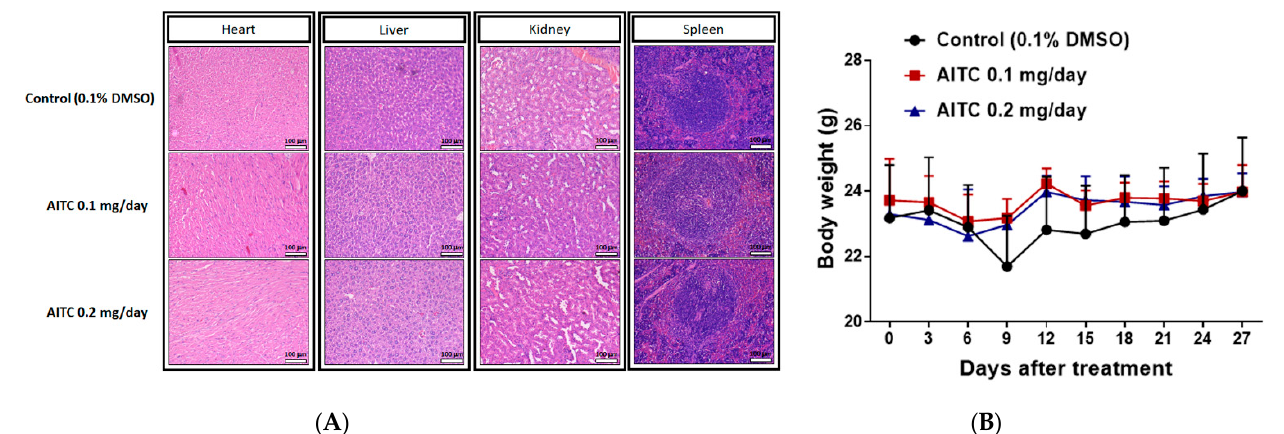
Figure 4. The examinations of AITC-induced toxicity from xenograft GBM8401/ luc2 -cell-bearing mice. After treatment, tissues of the heart, liver, kidney, and spleen were isolated from each mouse and used in H&E staining for further examination of the pathology under the microscope at 100 times magnification, as described in the Materials and Methods ( A ). Mouse body weights of control and AITC-treated groups from day 0 to day 27 are recorded and quantified ( B ). Each section was imaged with 3 independent fields. (Scale bar = 100 µm, with 200× magnification). Table 1. The alteration of pathology was defined as the following 4 severity scores: 0—regular